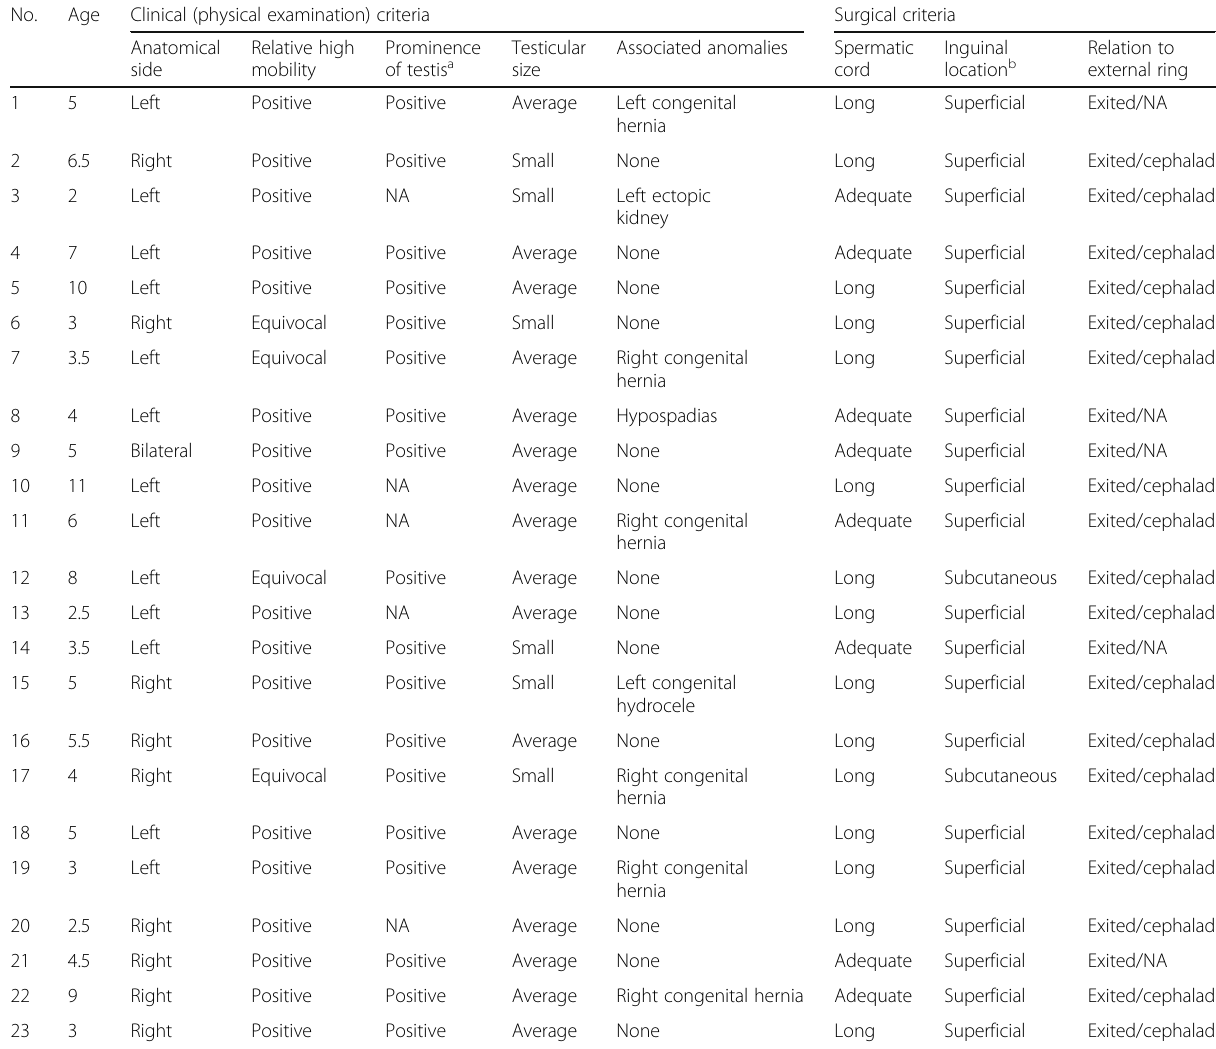
Table 2 Characteristics of the cases of inguinal testicular ectopia